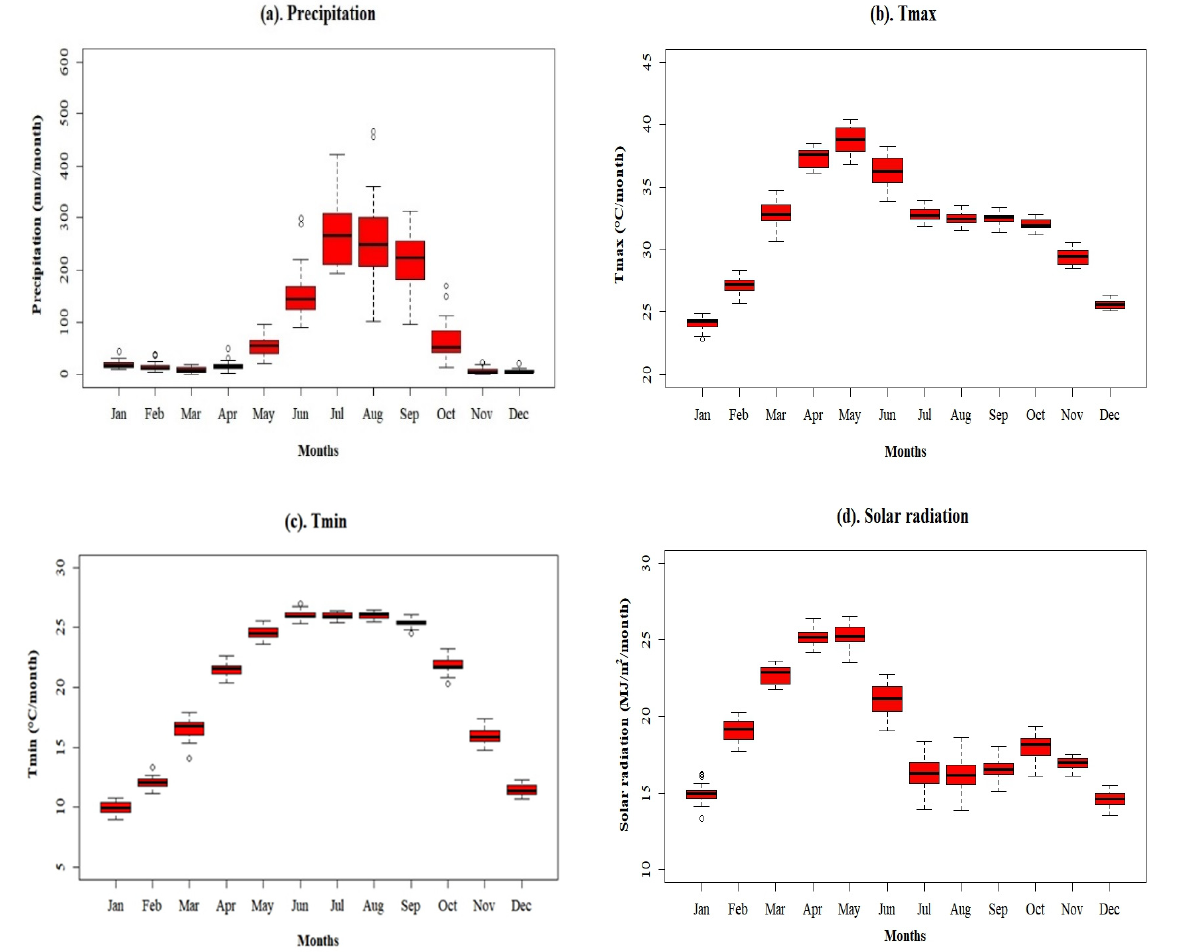
Figure 3. Box and whisker plot of the ensemble mean of climate simulated data from all four selected models for the baseline period (1980–2004).